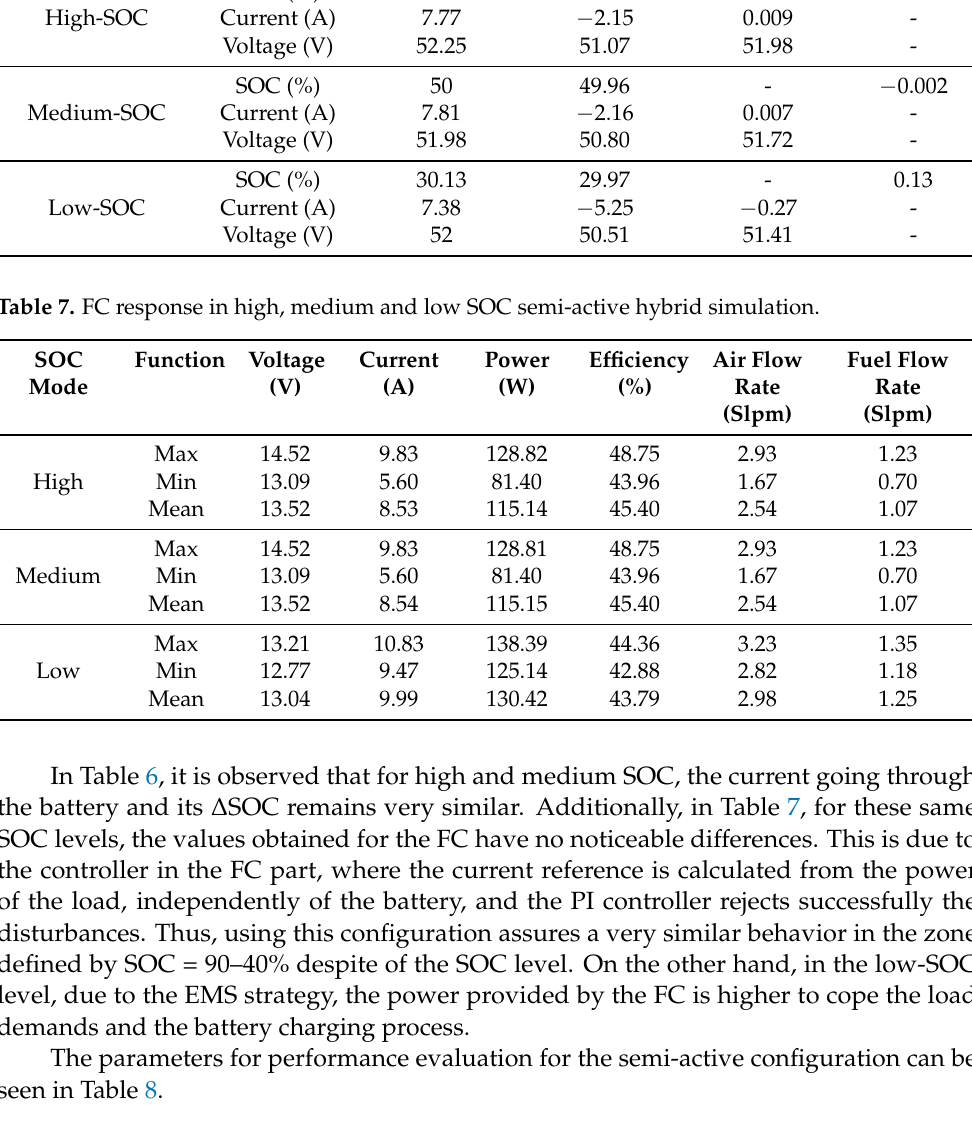
Table 8. Performance parameters of the semi-active hybrid